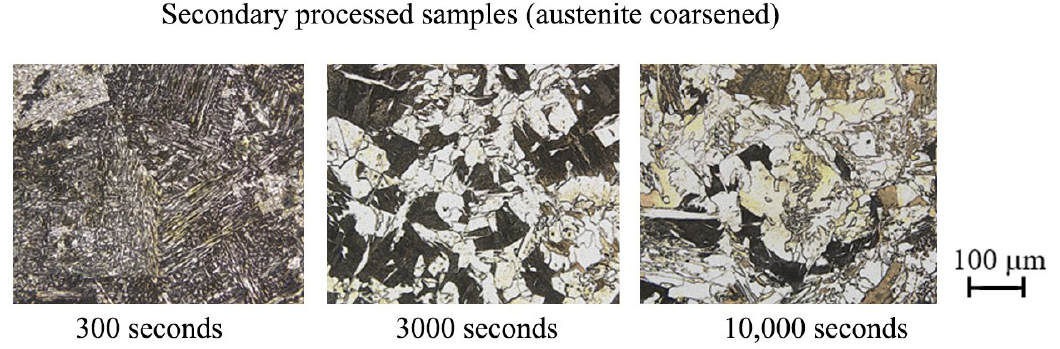
Figure 5. Microstructure of austenite coarsen (AC) samples at different inter-critical annealing times at a temperature of 630 °C. All micrographs shown at the same magnification.